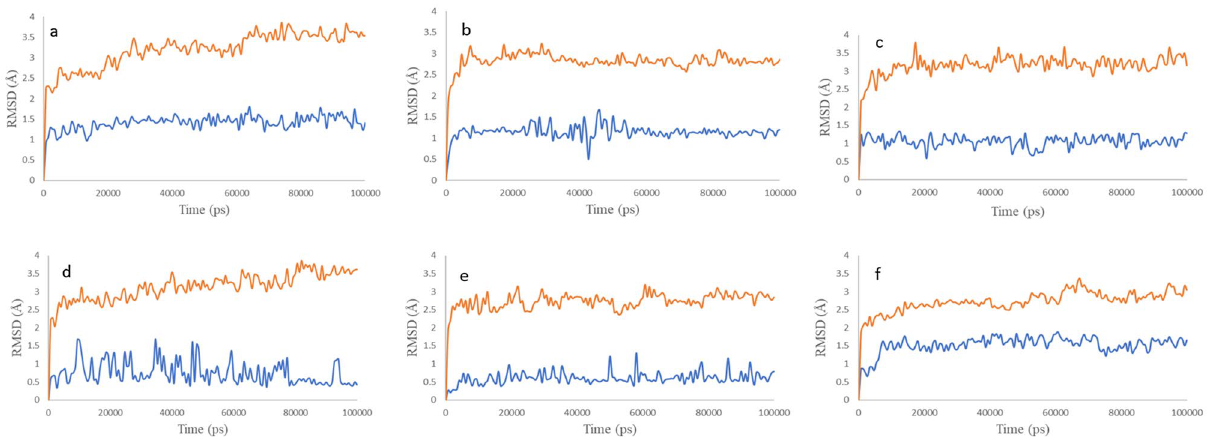
Figure 4. RMSD plots of the six top-scored complexes, ( a – f ) (3L3M-valganciclovir ( a ), 3L3M-ganciclovir ( b ), 3L3M-penciclovir ( c ), 4U80-entecavir ( d ), 3OG7-entecavir ( e ) and 5VAM-valganciclovir ( f ); the red colored graphs indicate the RMSD of proteins and the blue colored graphs indicate the RMSD of ligands inside the